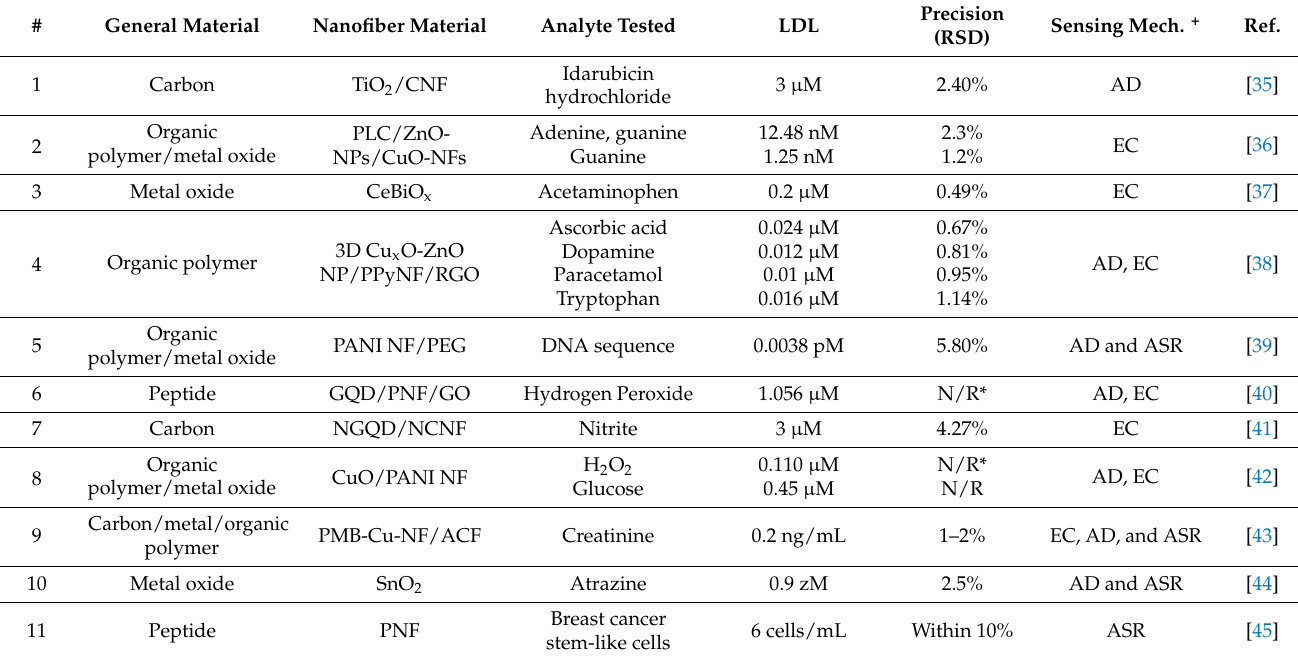
Table 1. Eleven nanofiber sensor examples with reported lower limit of detection (LDL) and precision or relative standard deviation (RSD). LDL indicates the general sensitivity of the sensor. RSD is chosen to show the general consistency of the measured sample. The # will consistently be used for Tables 2 and